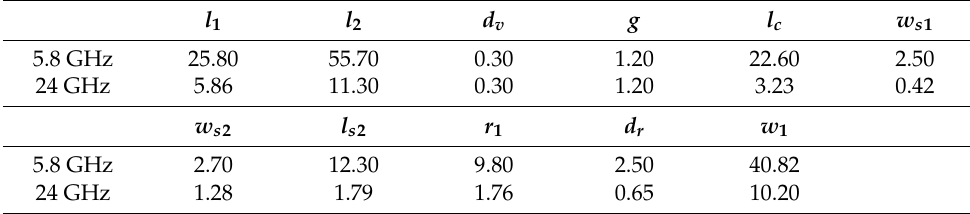
Table 2. Dimensions of designed antennas.